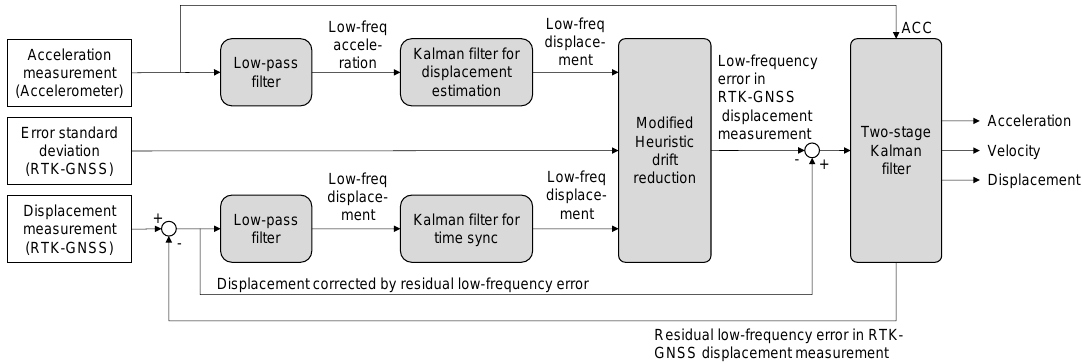
Figure 1. Schematic diagram of the proposed method.